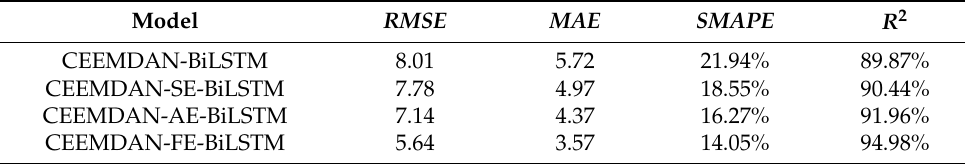
Table 4. Prediction error of PM 10 concentration prediction